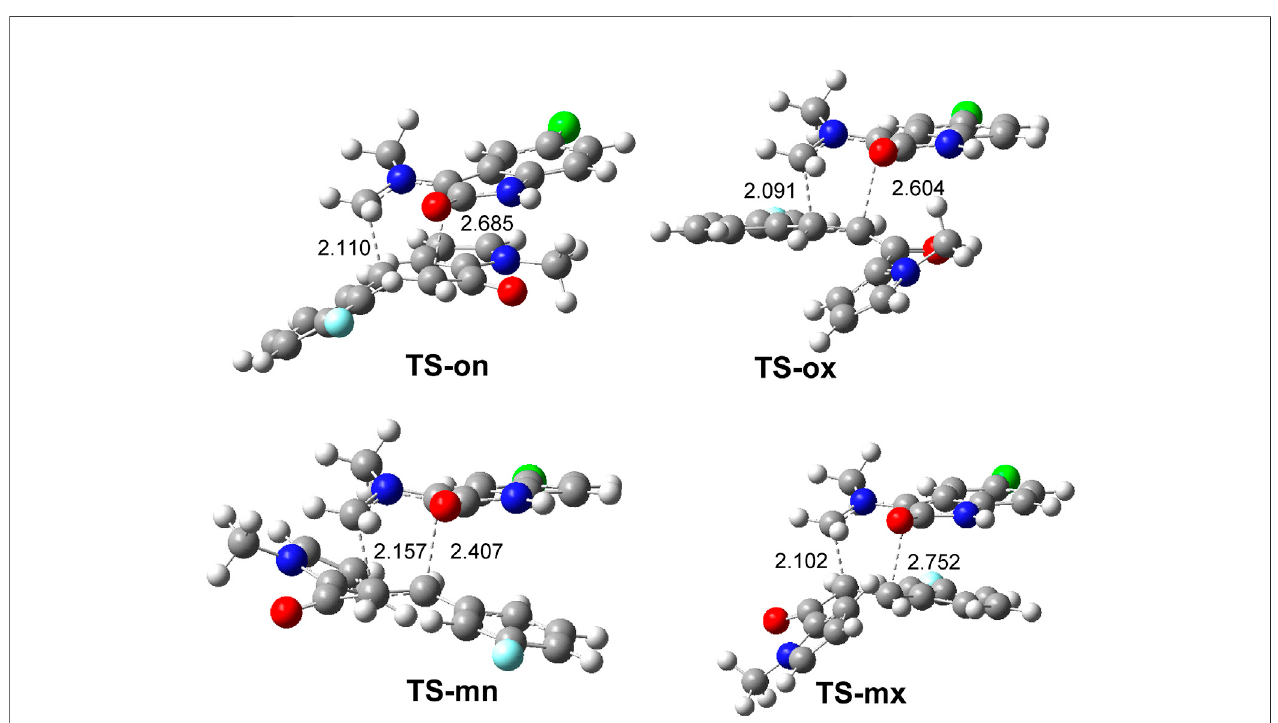
FIGURE 9 | ω B97X-D/6-311G(d,p) geometry of TSs in methanol. The distances are given in Angstrom.